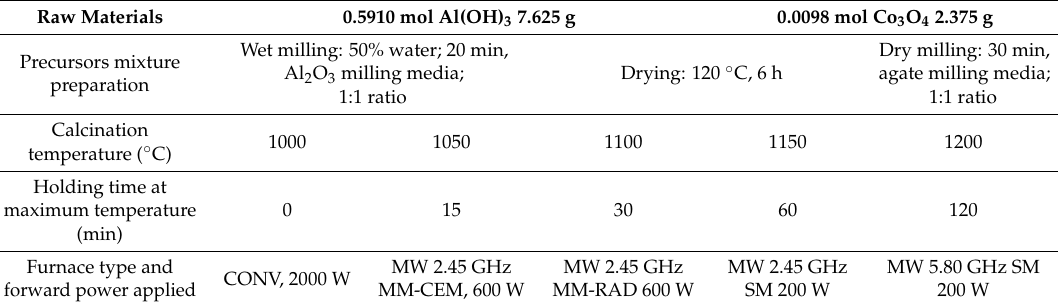
Table 1. Summary of experimental conditions for each sample (10 g mixture). CONV =